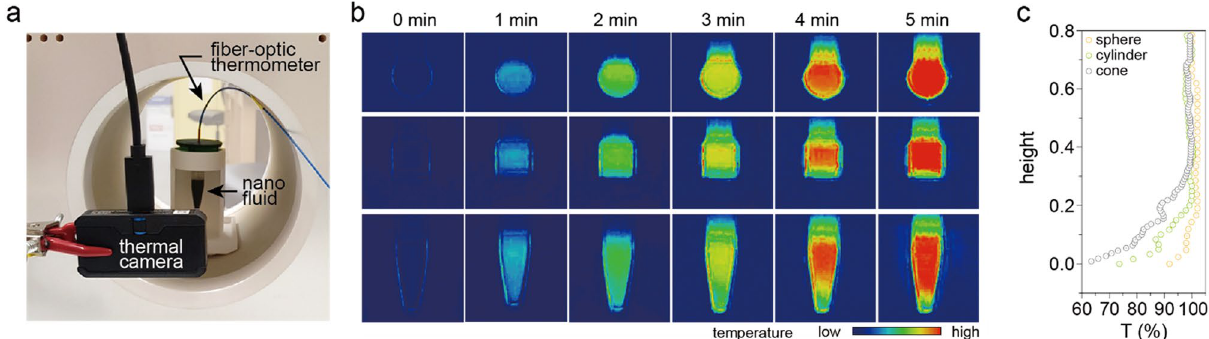
Figure 2. The surface temperature measurement of different sample containers during AC heat induction. ( a ) A picture of the experimental setup. ( b ) The thermal images of spherical- (top), cylindrical- (middle), and cone (bottom)- shape sample containers during application of AC magnetic field ( f appl = 100 kHz, H appl = 140 Oe) for 5 min. ( c ) The surface temperature distribution obtained from thermal images of each sample container. The 100% of temperature represents the maximum temperature measured at each sample